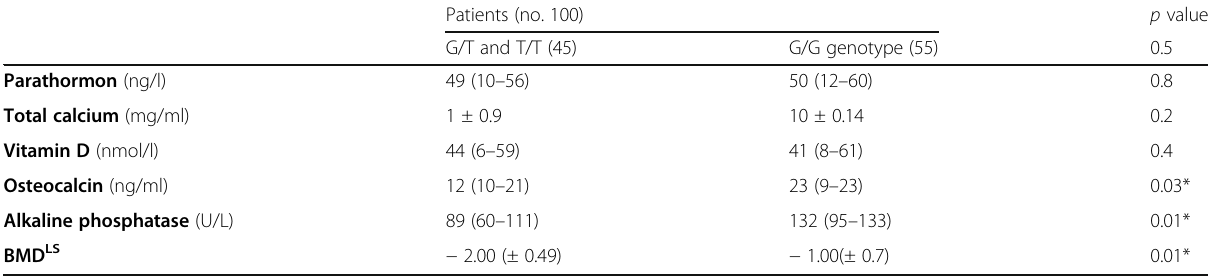
Table 2 Comparing patient group G/G variant versus G/T and T/T variants regarding laboratory data and BMD LS at diagnosis (the first assessment)